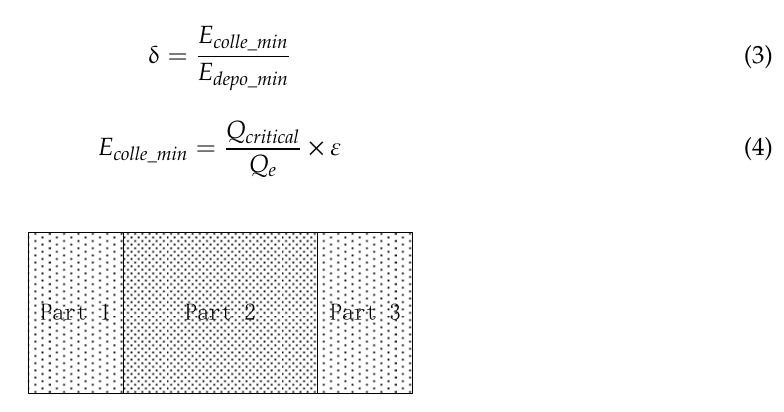
Figure 5. The divided sensitive volume.